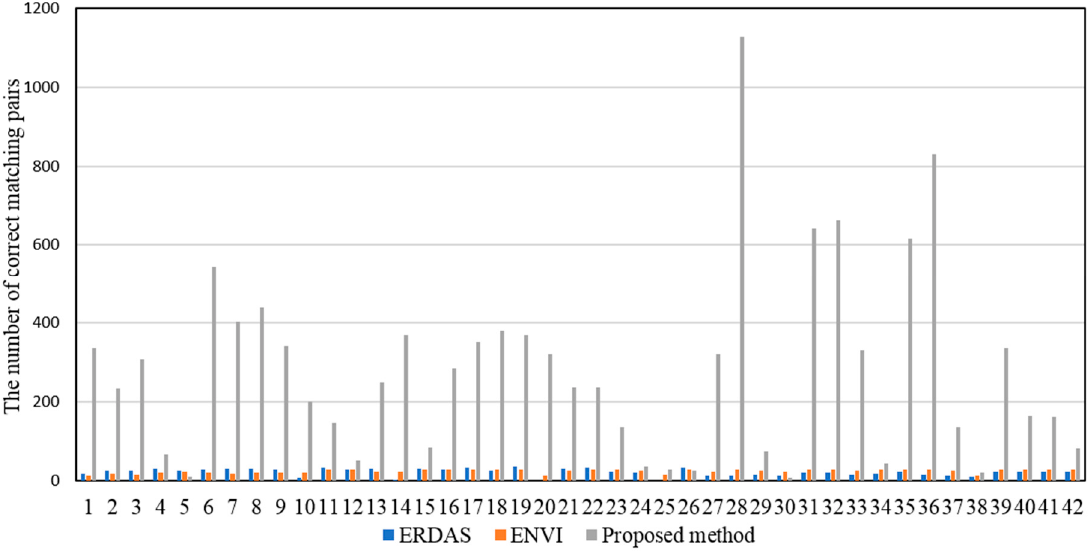
Figure 16. Comparison of the number of correct matching pairs from ERDAS, ENVI, and the proposed method.